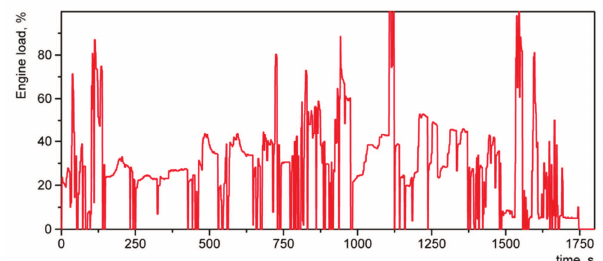
Fig. 4. Load as a function of driving